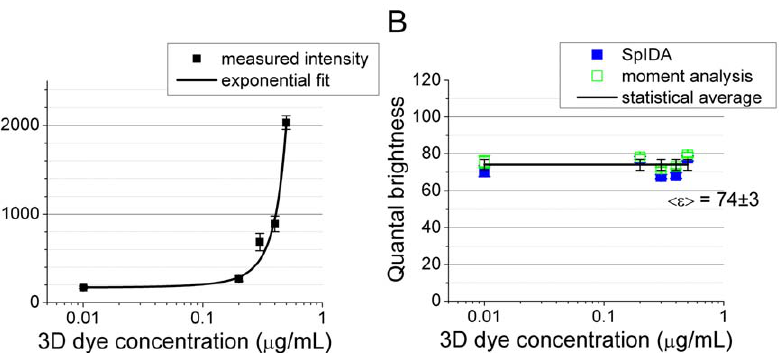
Figure 3. Quantal brightness of Alexa Fluor 488 measured for 2D samples prepared with different values of concentration in 3D solution. (A) Mean intensity measured from ROIs. (B) The values of the quantal brightness measured with fluorescent image moment analysis and SpIDA as a function of the dye concentration in solution. The error bars were calculated as the standard error of multiple images taken at different locations in the sample.